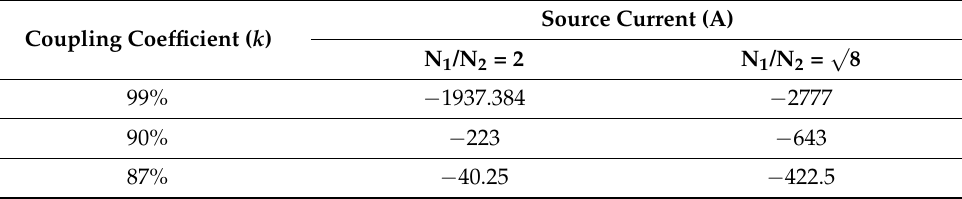
Table 3. Minimum values of the source current with deferent values of the turns-ratio and k.